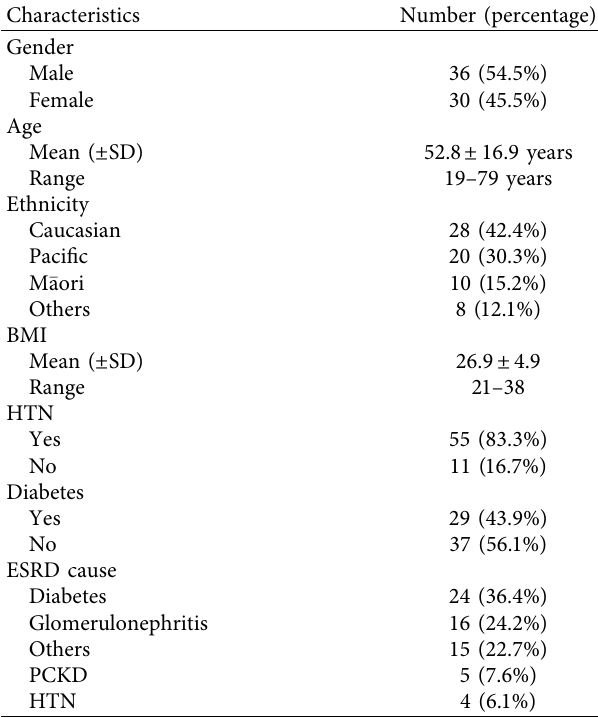
Table 3: AVF procedural factors and outcomes. Table 1: Patient demographics, comorbidities, and ESRD